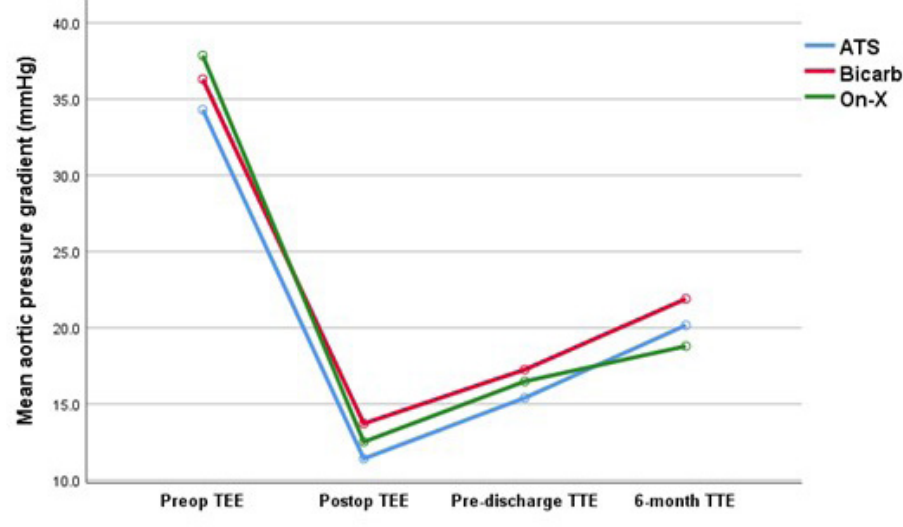
Fig. 2 - Estimated marginal means of aortic valve mean pressure gradients (MPG) at four-time points (preoperative transesophageal echocardiography [TEE], postoperative TEE, pre-discharge transthoracic echocardiography [TTE], and six-month follow-up TTE) for the three valve types (ATS, On-X, and Bicarbon) adjusted for valve sizes. Repeated measure analysis did not show a significant difference in MPG between the three aortic valve types over the four-time points (Wilks’ Lamda P=0.08). However, the change in MPG across the four-time points